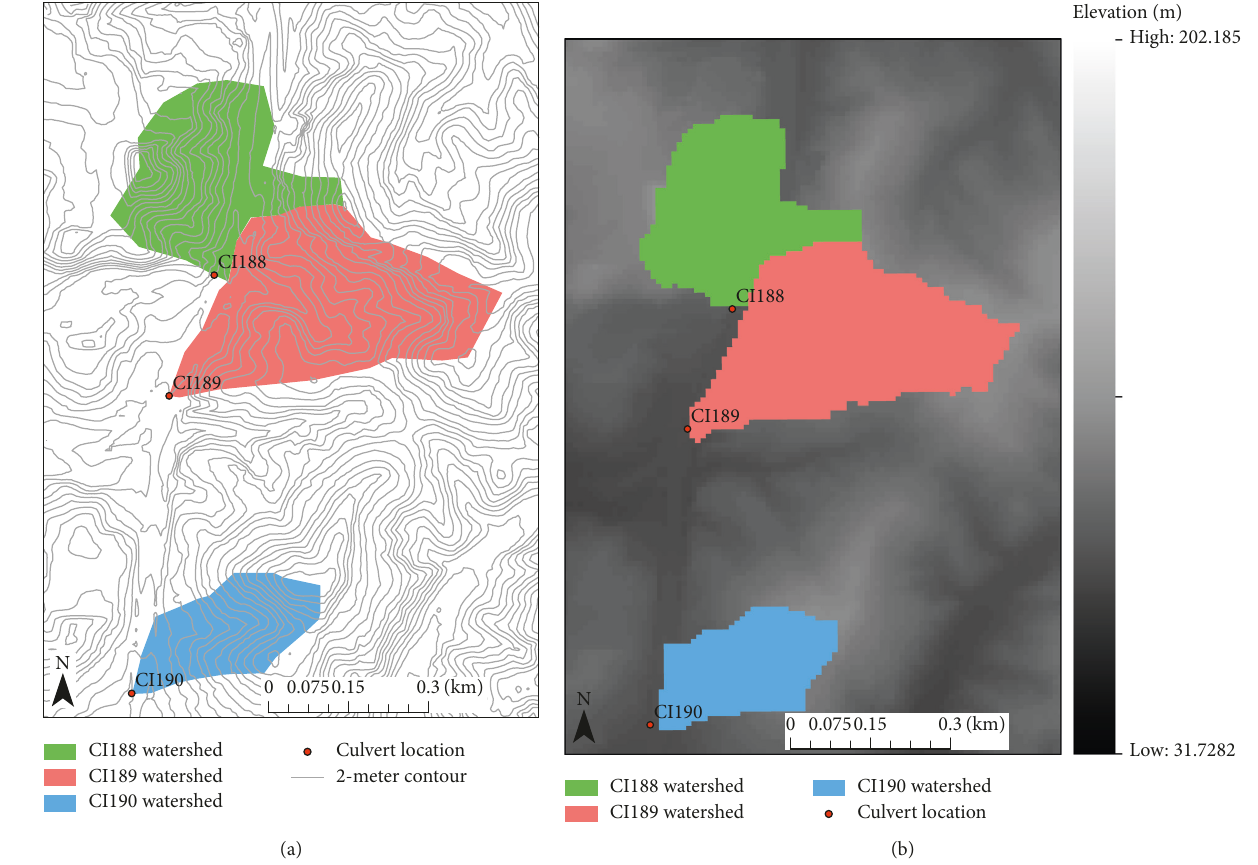
Figure 4: Three Tuscaloosa culvert drainage basins delineated (a) by hand through use of a contour map and (b) through raster-based methods using a 10-meter DEM.